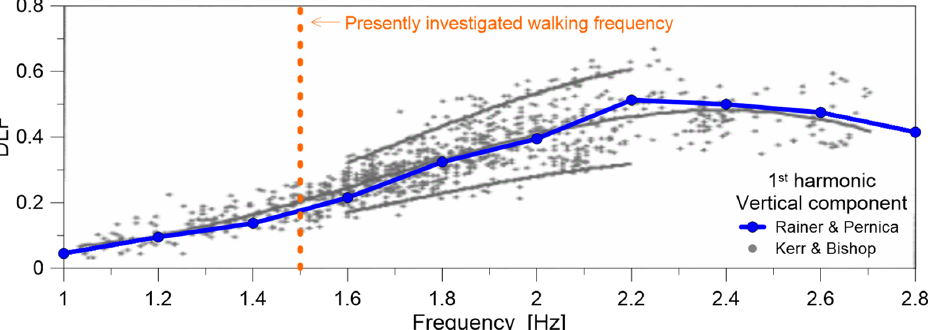
Figure 3. Experimental derivation of DLF values from comparative data discussed in Rainer & Pernica [7] and Kerr & Bishop [24], for pedestrians walking in the range f p = 1 ÷ 3 Hz. In evidence, the DLF for the first harmonic and the presently explored walking frequency ( f p = 1.5 Hz). License agreement 5418101331812 from Elsevier ® (October 2022).